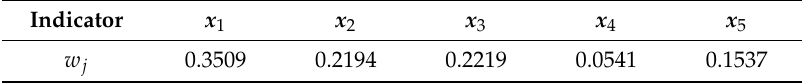
Table 7. The weight of each indicator according to the information entropy